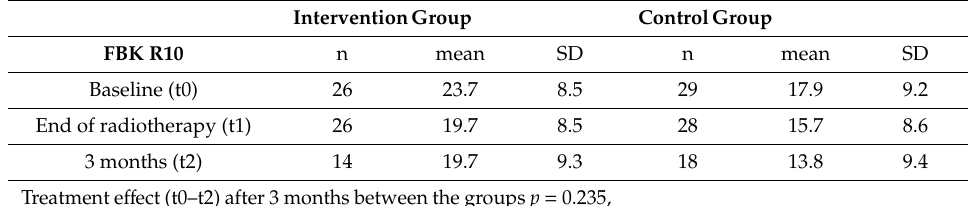
Table 6. E ff ects on emotional distress according to FBK-R10 questionnaire.